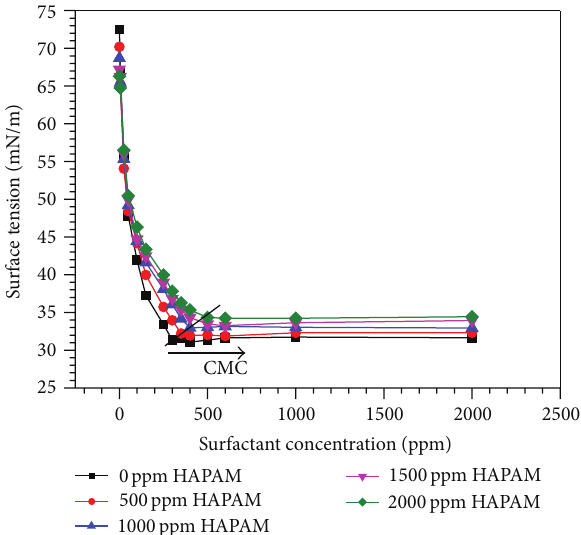
Figure 5: Effect of HAPAM concentrations on the dynamic interfa- cial tensions of